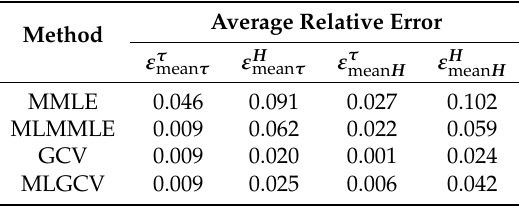
Figure 1. Relative errors ε τ mean , ε τ max , ε H mean , and ε H max versus τ t for H t = 3.0 km. All four aerosol models are involved in the retrieval. Table 2. Average relative errors for the results plotted in Figures 1 and 2. MMLE, Maximum Marginal Likelihood Estimation; GCV, Generalized-Cross